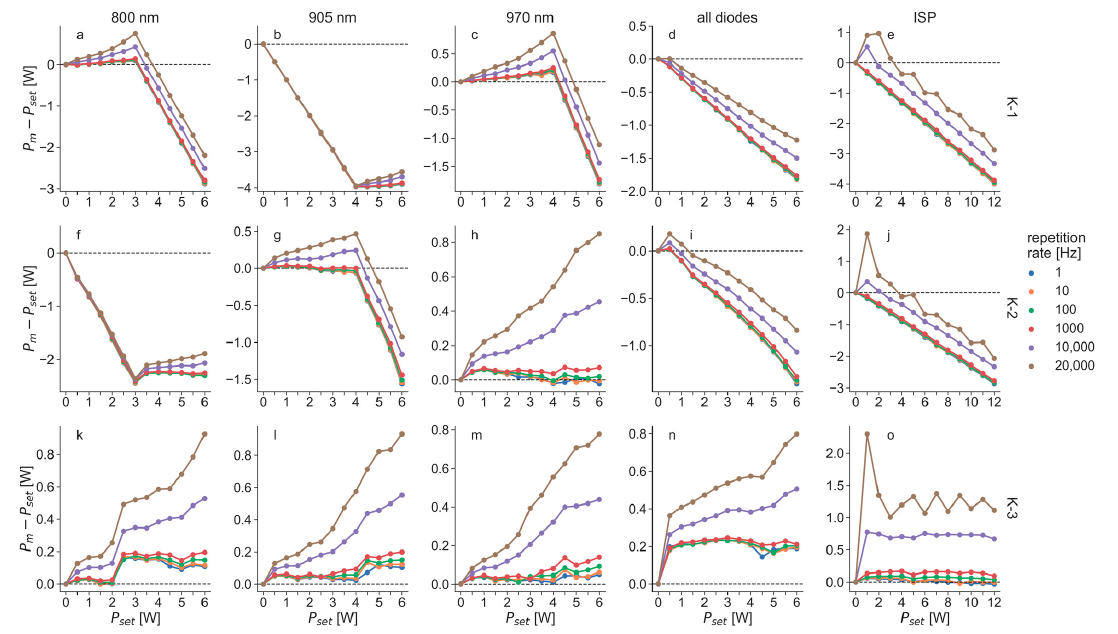
Figure 5. Difference between set powers ( P set ) and measured powers ( P m ) of the three K-lasers (K1, ( a – e ); K-2, ( f – j ); K-3, ( k – o )) operated in pulsed wave (PW) mode at varying repetition rates. The lasers were measured using each wavelength individually: ( a , f , k ), 800 nm; ( b , g , l ), 905 nm; ( c , h , m ), 970 nm; they were also measured using all diodes simultaneously: ( d , i , n ), all diodes. In addition, they were measured in intense super pulse (ISP) mode, which is also using all diodes but in a different pulsing mode: ( e , j , o ), ISP. Dashed horizontal lines at zero in each diagram illustrate ideal curves where P m equals P set . lasers emitted up to three times the amount of power than expected ( 𝑃 (cid:3040) at 𝑃 (cid:3046)(cid:3032)(cid:3047) = 1 W and 20 kHz: K-1, 1.91 W; K-2, 2.87 W; K-3, 3.30 W). Since this was observed for all three units,